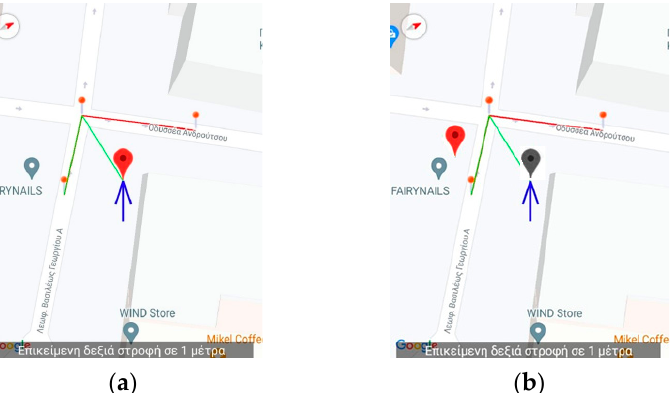
Figure 7. Application’s Training version—Snapshot from a simulated route ( a ) while it is being replayed. The instructor pauses the replay and selects to move the position of the user in an arbitrary location on the map in order to demonstrate the behavior of the app when a wrong turn event occurs. Upon selecting the new position, the old is grayed out ( b ). The text in both figures displays the message when the instructor paused the replay: “Upcoming right turn in 1 meter